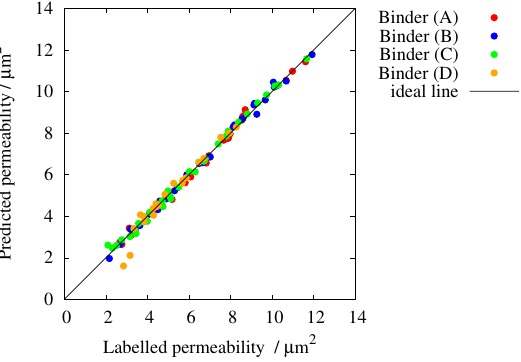
Figure 8. Predictions on the out-of-sample data; coloring according to the binder model: (A) b r = 6 µm; (B) b r = 18 µm; (C) b r = 30 µm; (D) b r = ∞